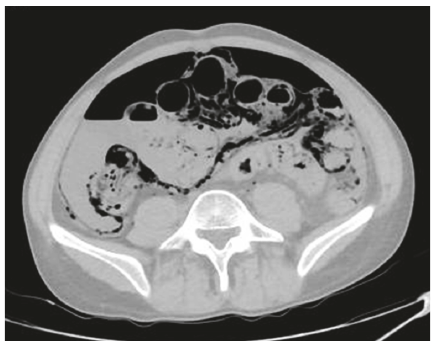
Figure 1: Postmortem CT, axial view, revealing pneumatosis intesti- nalis along the small bowel and right colon along with free air and unclear fluid in the peritoneal cavity.